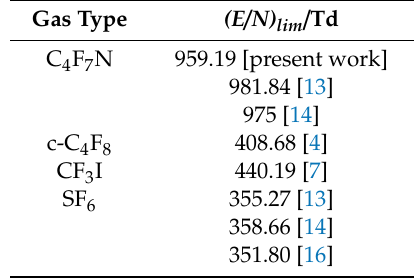
Table 1. The values of (E/N) lim in different gases.